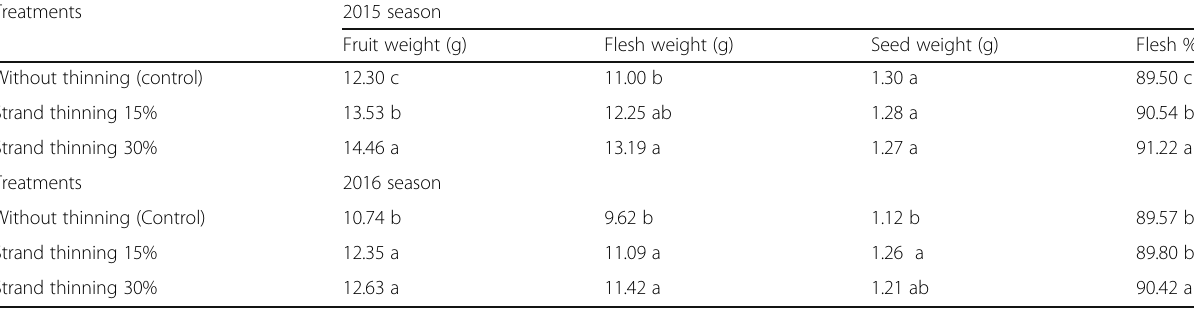
Table 2 Effect of strand thinning treatments on fruit weight, flesh weight, seed weight, and flesh % of Khadrawi date palm cultivar at rutab stage during 2015 and 2016 seasons